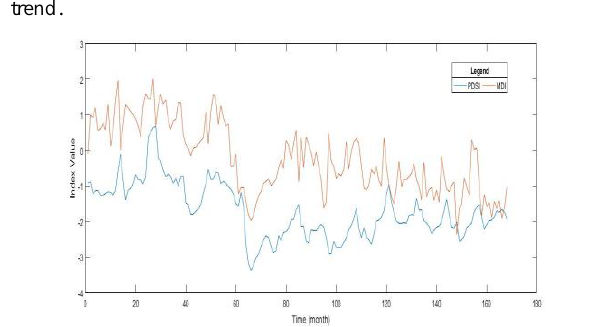
Figure 2. Relation between PDSI and